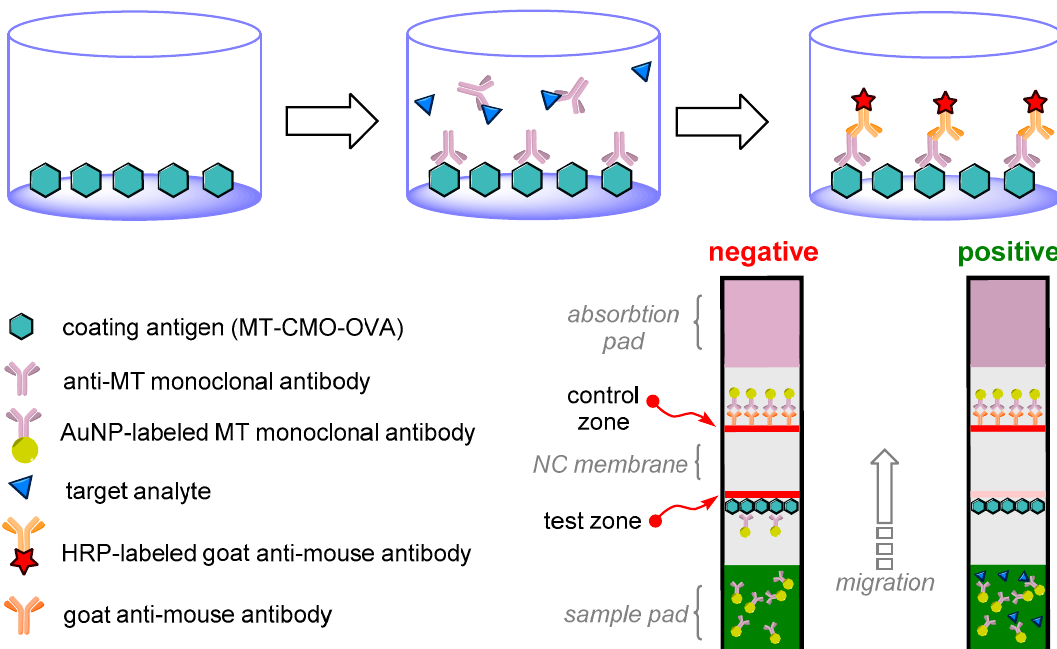
Figure 2. A diagram depicting the principle of indirect competitive enzyme-linked immunosorbent assay (ELISA) and the composition of an immunochromatographic test. NC: nitrocellulose; MT: methyltestosterone; MT-CMO-OVA: a conjugate of methyltestosterone-3-carboxymethyloxime with ovalbumin; mAb: mouse-derived antibody against MT; HRP: horseradish peroxidase [91].